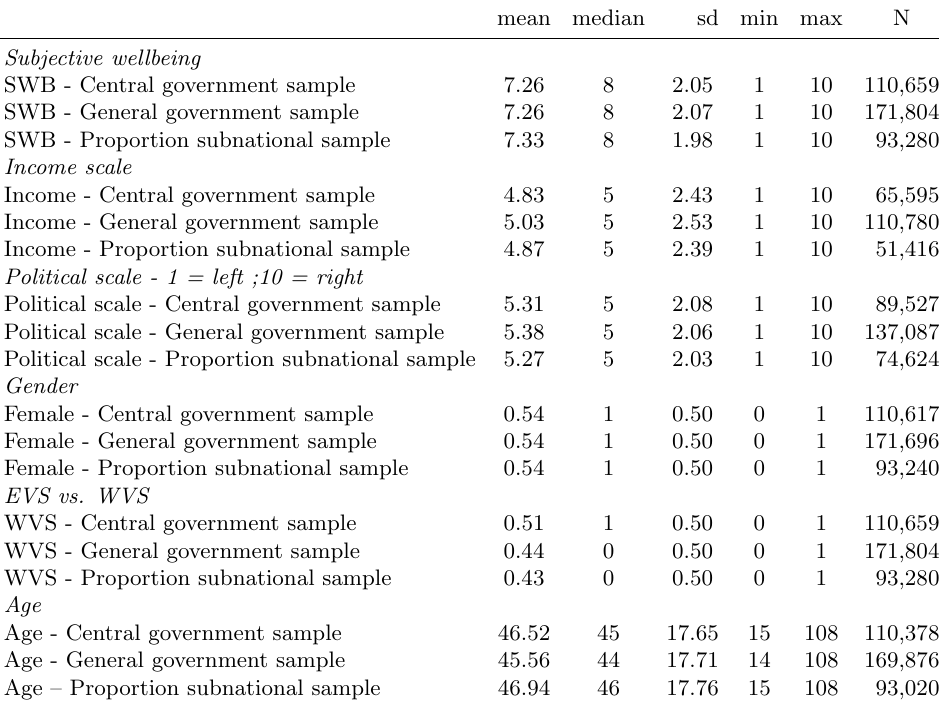
Table A.3: Individual level variables summary